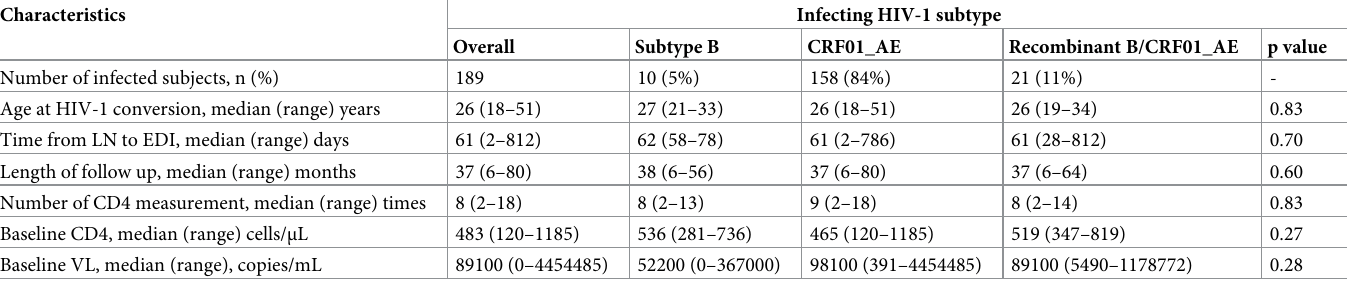
Table 1. Baseline characteristics of MSM infected with HIV-1 subtype B, CRF01_AE and recombinant B/CRF01_AE, Bangkok Men Who Have Sex with Men Cohort Study, Bangkok, Thailand, 2006–2014.